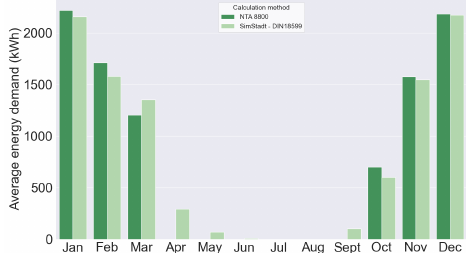
Figure 16. The differences between the average energy demand values calculated with NTA 8800 and SimStadt for a 10-building